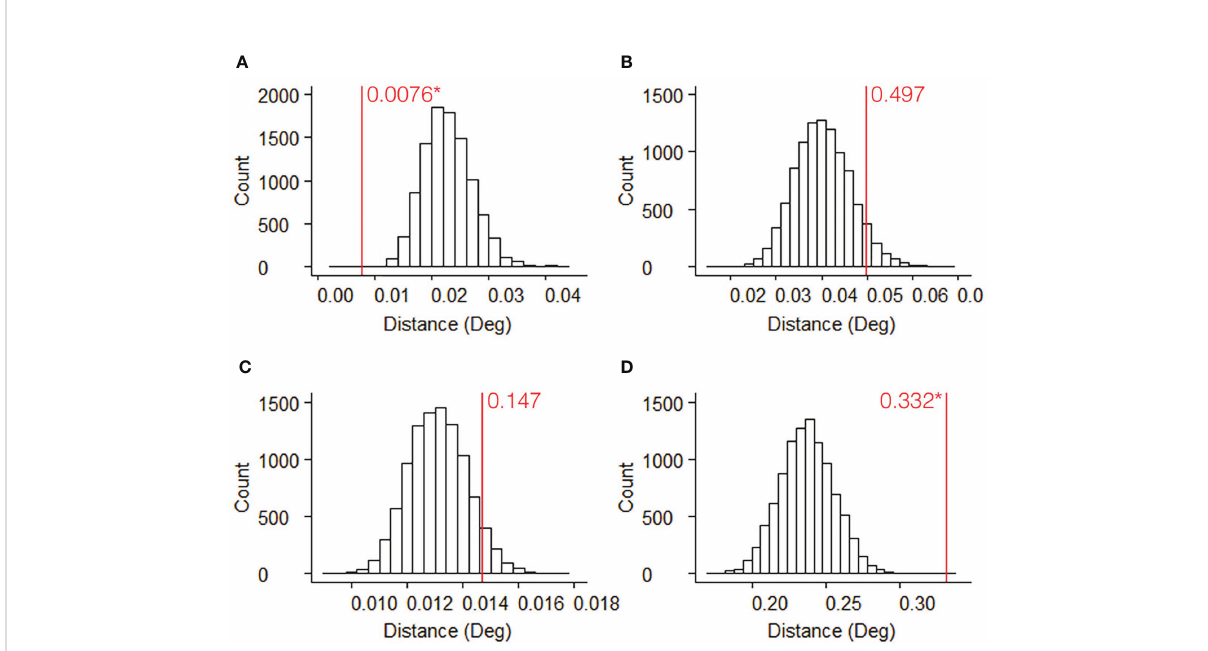
FIGURE 5 Comparison of simulated null distributions and mean observed distances (red bars and values) between porpoises and threats: (A) fi shing (summer); (B) fi shing (winter); (C) sand-mining (summer); and (D) sand-mining (winter). Asterisks denote signi fi cant differences at the 1%